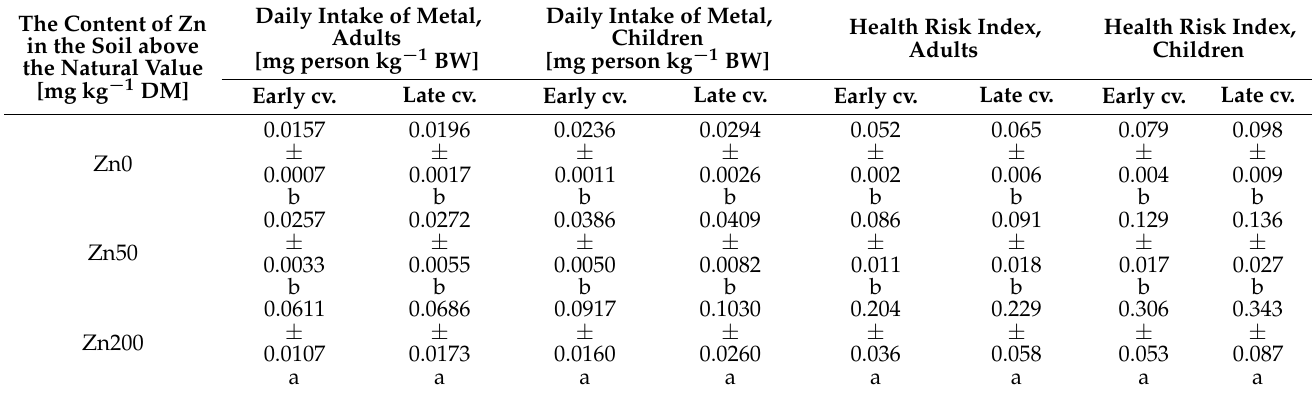
Table 4. Toxicological risk assessment (DIM and HRI) resulting from consumption of cabbages grown in unspiked soil and the soil spiked with zinc. The natural content of zinc in the Zn0 (control) object was 118.13 [mg kg − 1 DM]. The early cultivar was grown for 13 weeks, the late one for 21